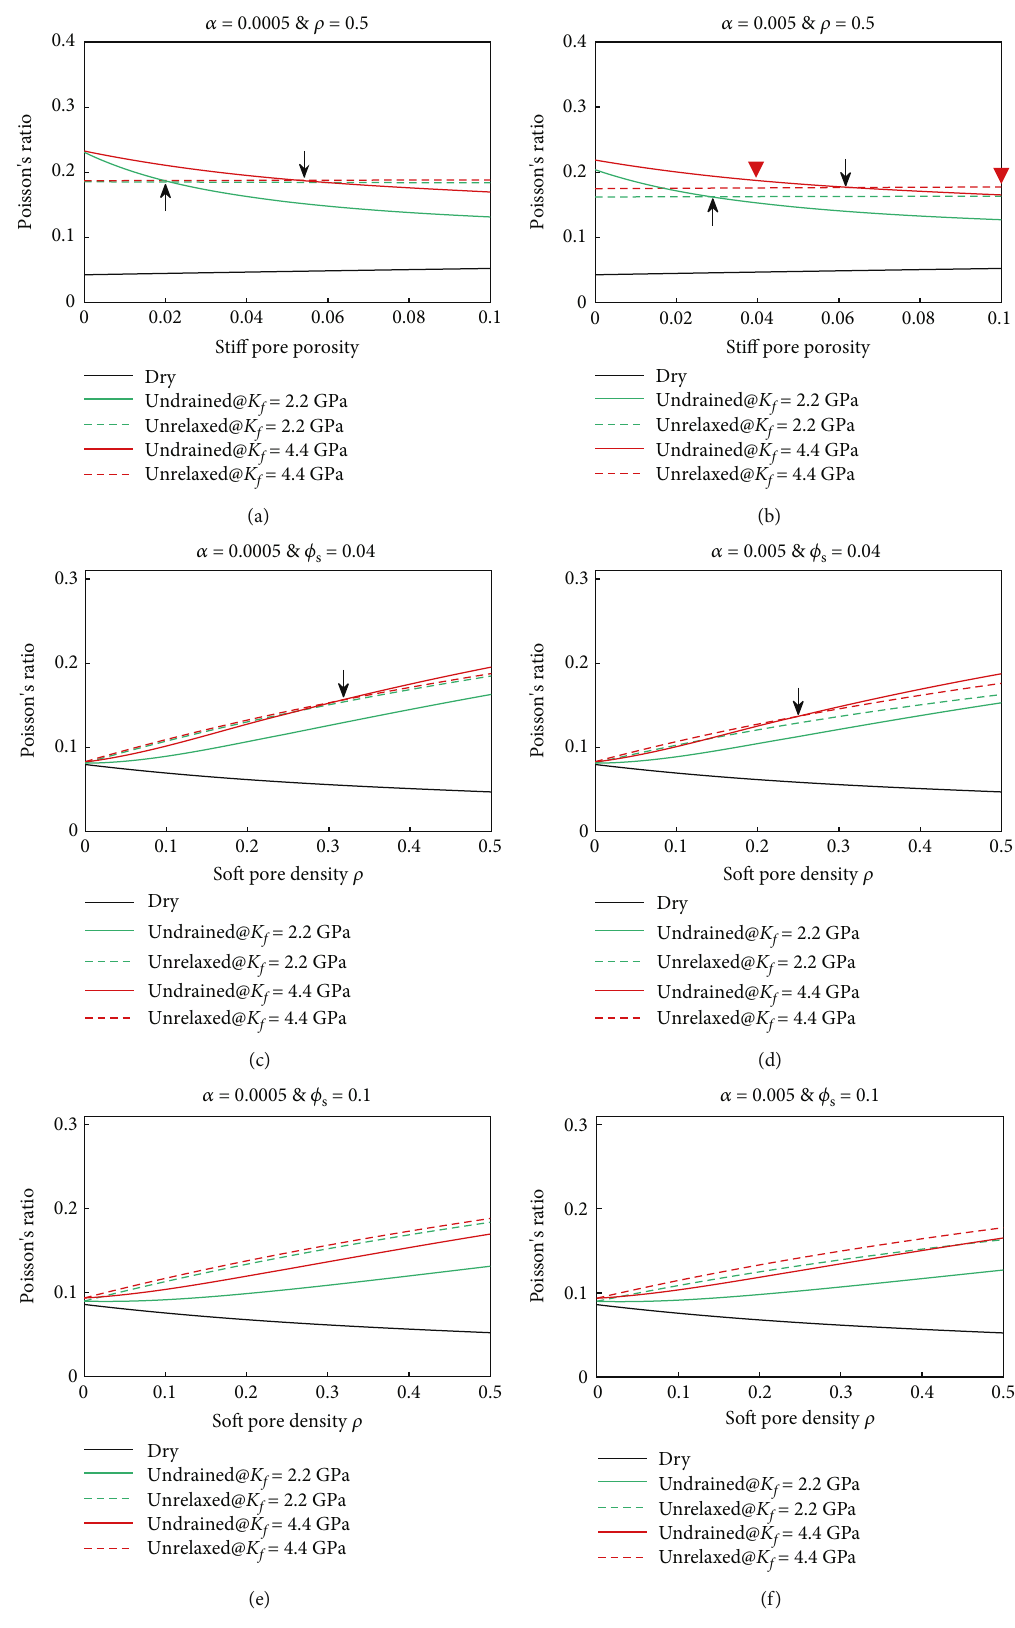
Figure 1: Modelling the e ff ect of in fl uence factors (i.e., the concentration of sti ff and soft pores, the aspect ratio of soft pores, and the pore fl uid bulk modulus) on Poisson ’ s ratio with the CPEM